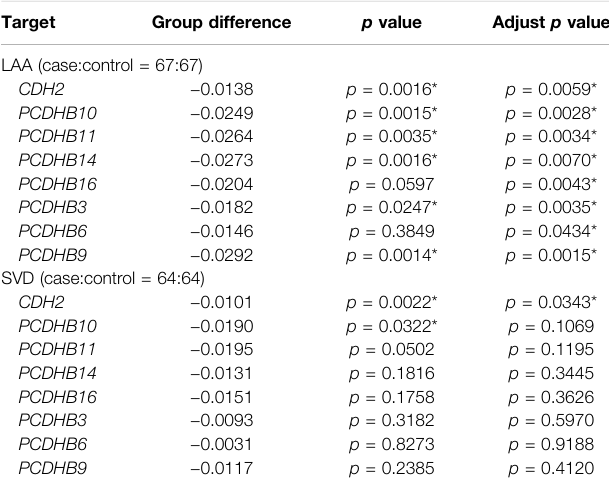
TABLE 5 | Strati fi ed analysis by ischemic stroke subtypes.